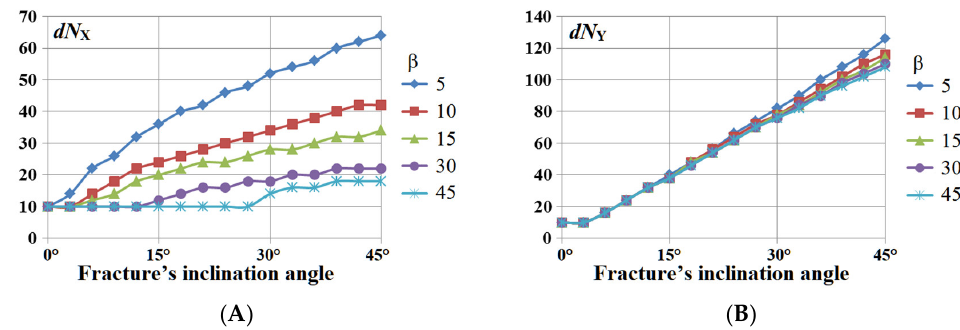
Figure 2. ( A ) Graphs of dN X and dN Y on the fracture’s inclination angle for h MIN = h /2 and h /4, β = 15 ◦ ; ( B ) graphs of the Courant number in background mesh on the fracture’s inclination angle for h MIN = h /2 and h /4, β = 15 ◦ .